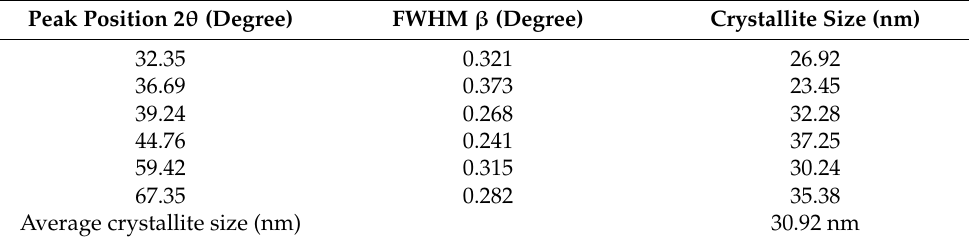
Table 1. The peak positions of X-ray Diffraction of Psidium guajava Co 3 O 4